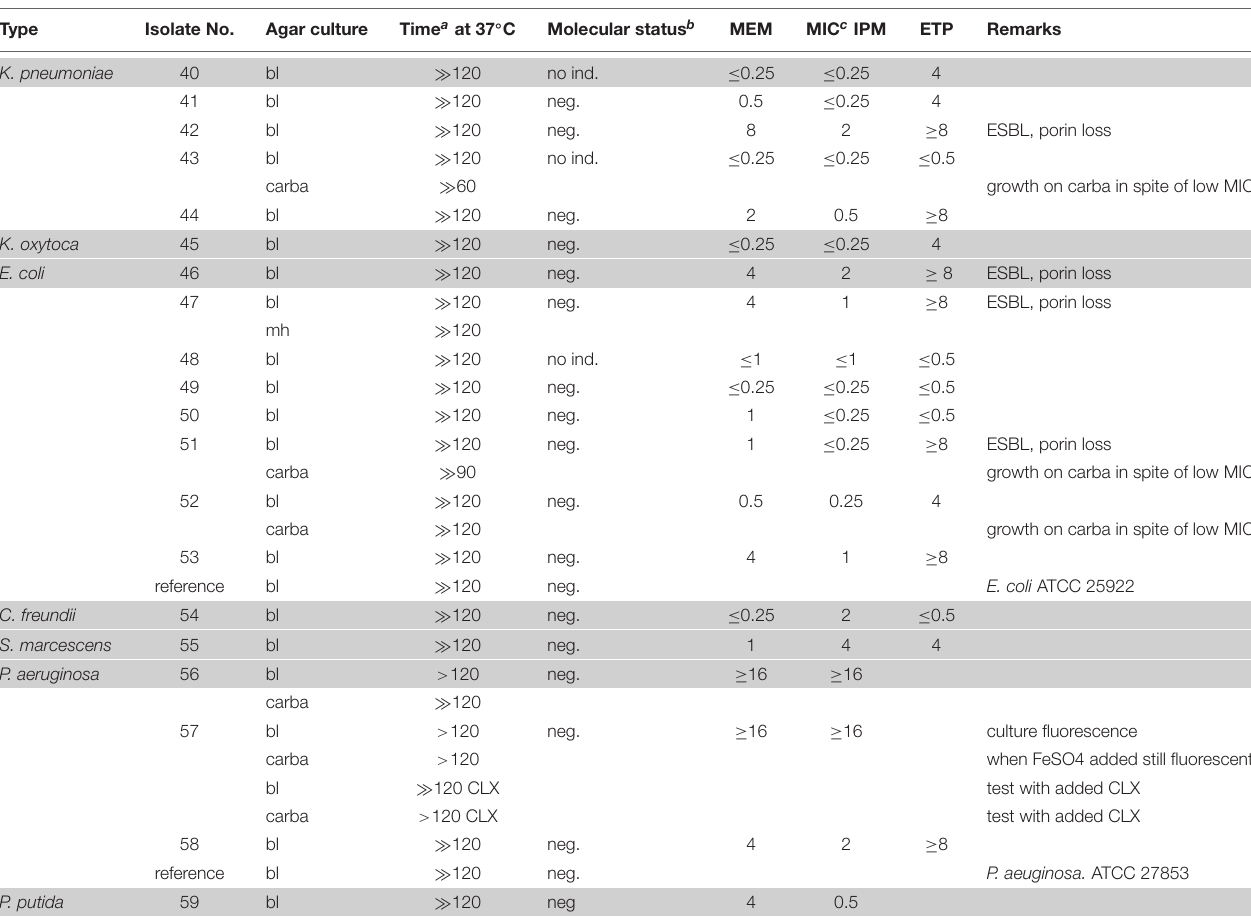
TABLE 2 | CarbaLux negative bacterial